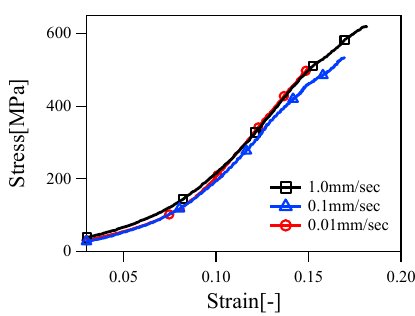
Figure 5. Uniaxial loading test.